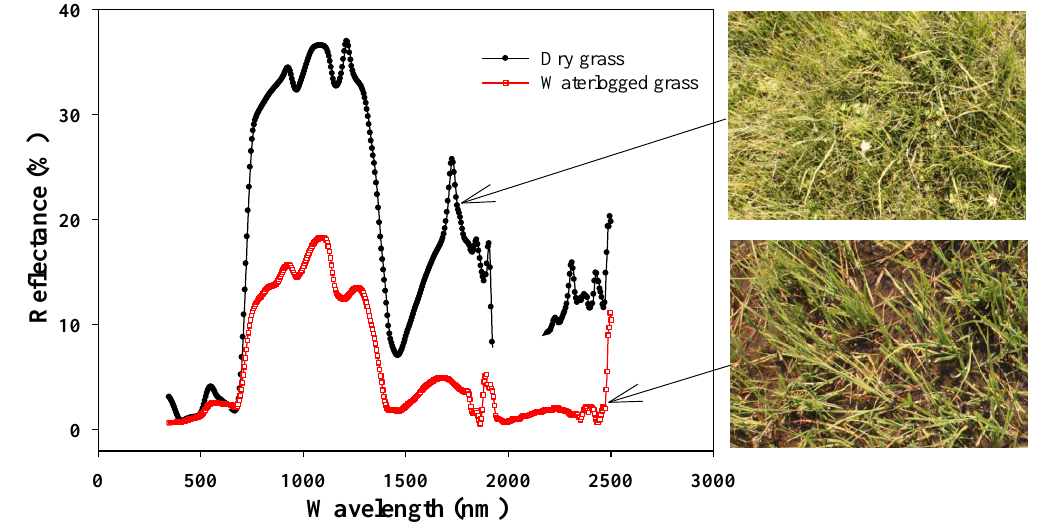
Figure 13. Spectra of the dry grass and waterlogged grass as measured by the field spectrometer.